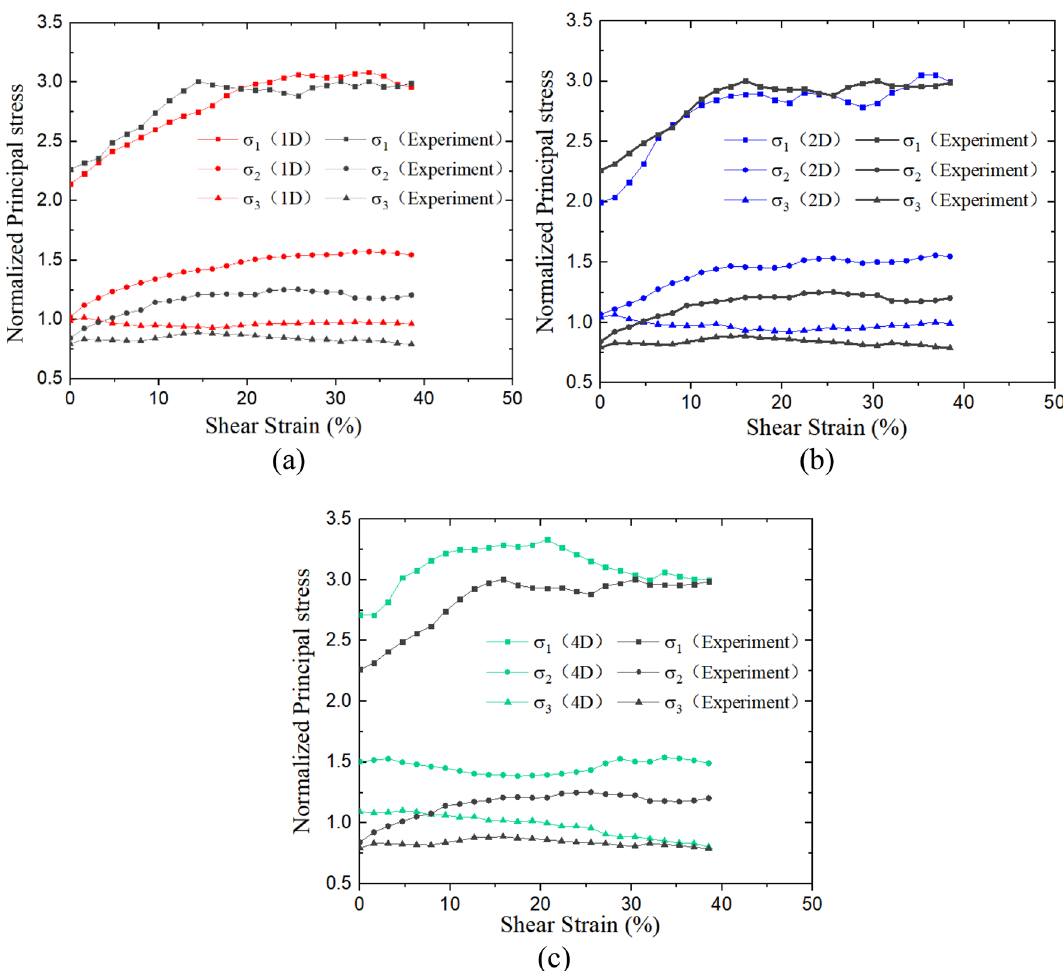
Figure 4. Principal stress and shear strain relations: ( a ) 1D model and Experiment, ( b ) 2D model and Experiment, ( c ) 4D model and